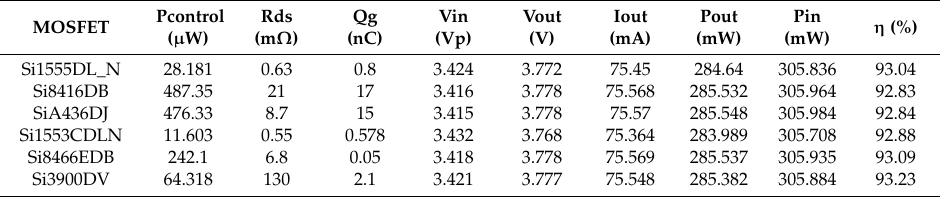
Table 5. Comparative results between different MOSFETs at 1 sun and 60 ◦